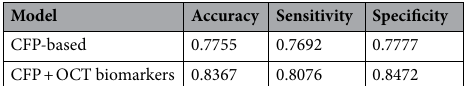
Table 4. Comparison of prediction performance in testing dataset between CFP-based model and the model combining CFPs and OCT biomarkers with stacking technique. After combining OCT biomarkers with stacking technique, the testing performance can improved to 83.67% in accuracy, 80.76% in sensitivity, and 84.72% in specificity.